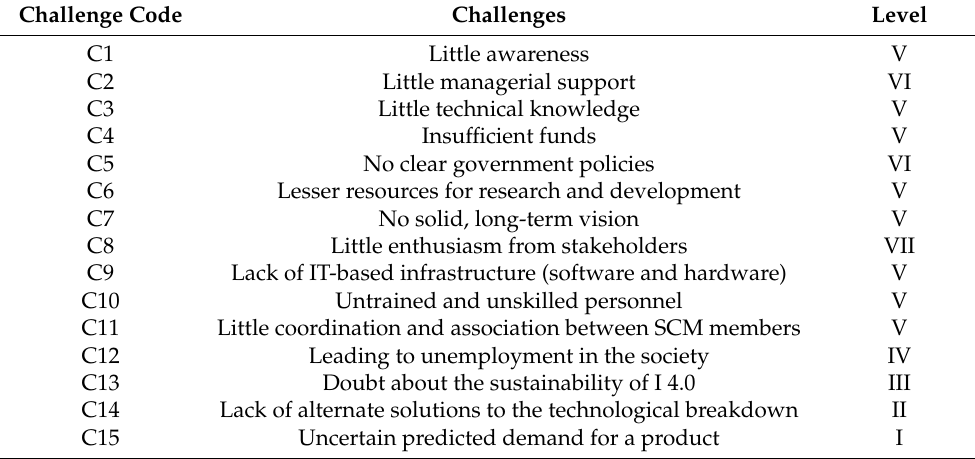
Table 10. Final level partitions from all iterations.